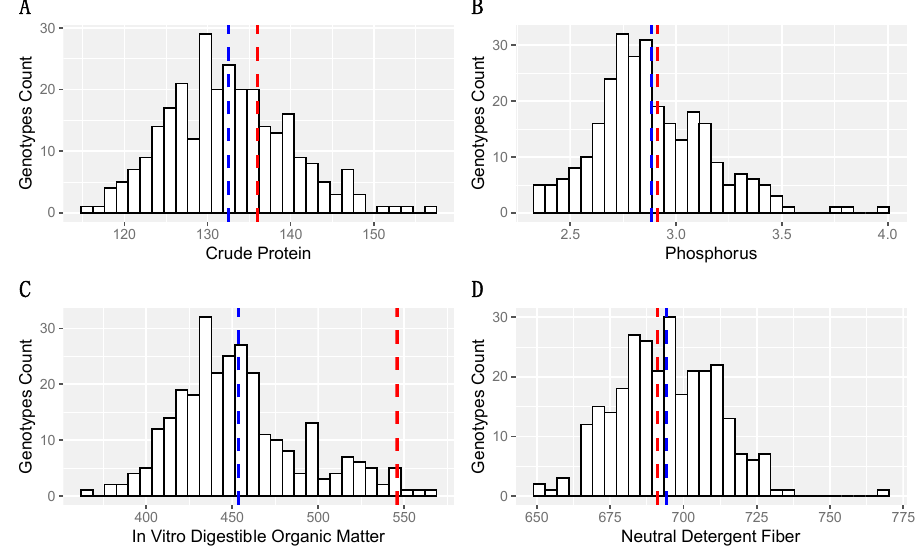
Figure 2. Histogram for four nutritive values traits using predictive values estimated for the USDA-NPGS bermudagrass germplasm collection and three checks: Tifton 85, Jiggs and Florida 44, evaluated in Citra, FL. ( A ) Crude Protein concentration, ( B ) Phosphorus concentration, ( C ) In Vitro Organic Matter Digestibility, and ( D ) Neutral Detergent Fiber, all expressed in g kg − 1 . The dashed blue line shows the means, while the dashed red line shows the values for Tifton 85 of each NV trait.